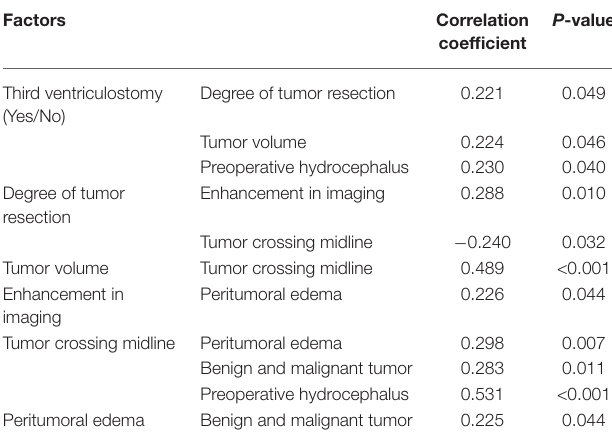
TABLE 5 | Spearman multivariate analysis and correlation coefficient ( p <